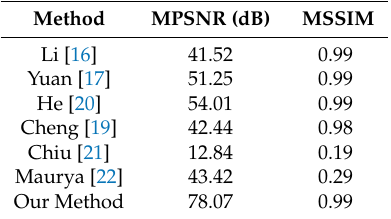
Table 9. The comparison on visual quality among different